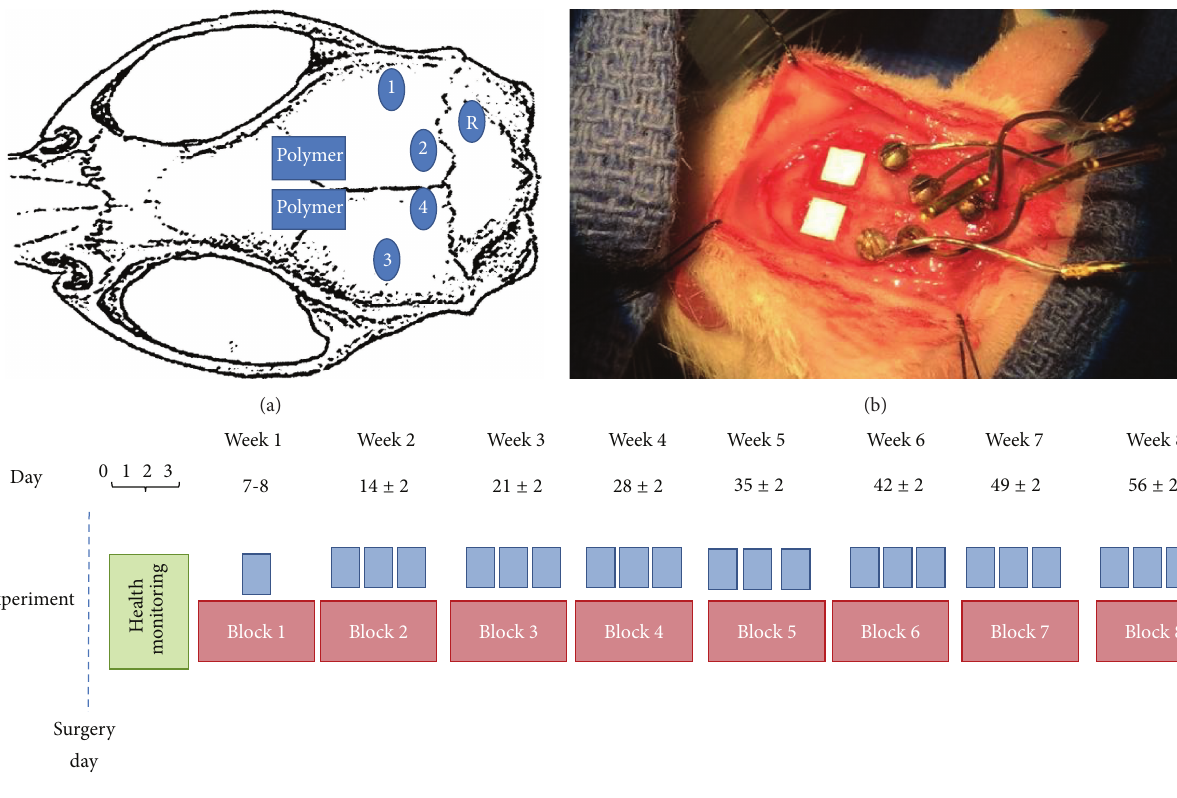
Figure 1: Schematic diagram illustrating the positioning of epidural recording screw electrodes (1–4), reference electrode (R) and polymer (a); picture of the actual surgery (b); timeline of the study design: for a minimum of three days after surgery the rats were monitored for weight loss once a day and for mobility and grooming twice a day. Thirty-minute electroencephalogram recording began at day 7 or 8 after surgery and for the following 7 weeks on 3 days per week. For each rat, the mean desired values (number of SWDs, duration of one SWD, or cumulative duration of SWDs over 30 min) were calculated for eight recording blocks, each block being 1 week of duration.